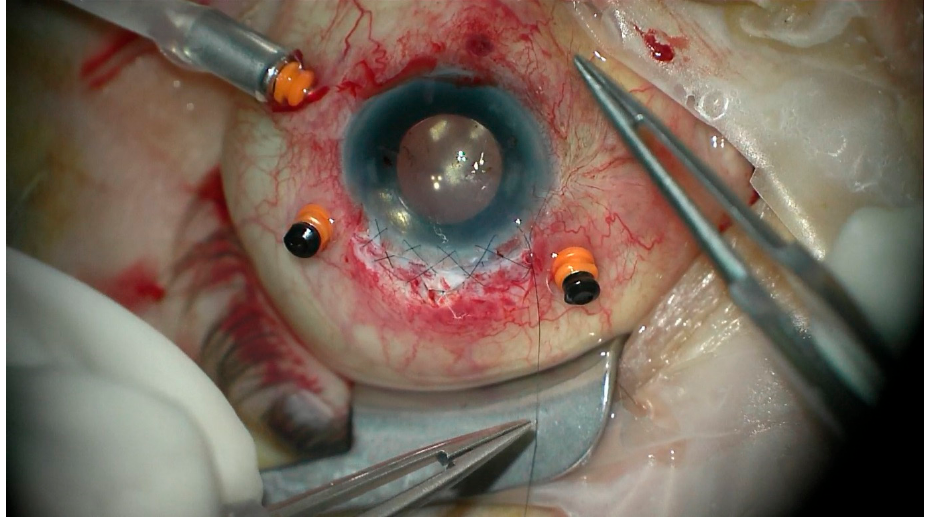
Figure 6. Implanting of black diaphragm intraocular lens while pulling the two sutures from the side.